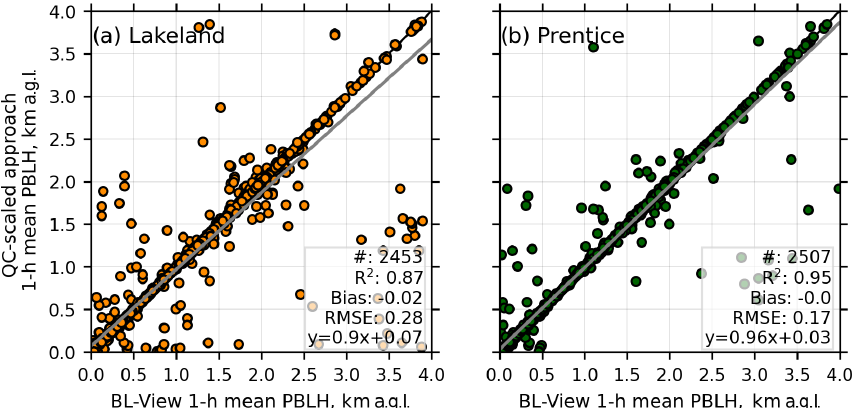
Figure 6. Scatterplots of PBLH estimates from the CL51 using the BL-View software output ( x axis) and the QC-scaled approach ( y axis) at the Lakeland (a) and Prentice (b) sites over the entire field campaign. Black lines represent the 1-to-1 line, and grey lines represent the best-fit